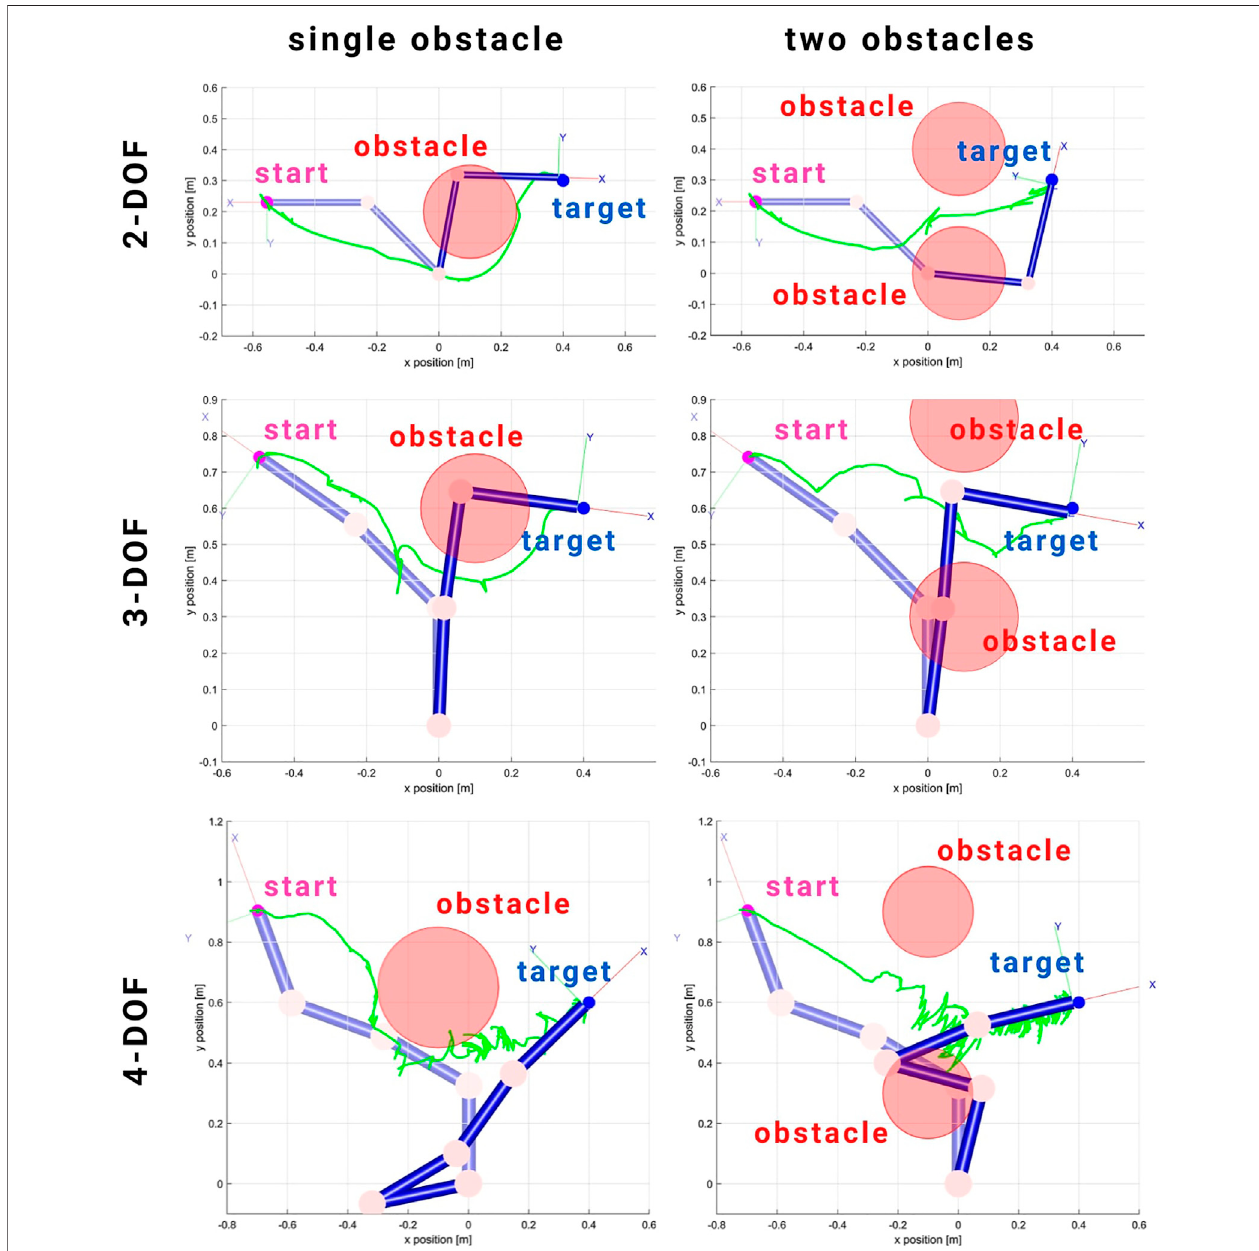
FIGURE 3 | Simulation results of simultaneous reaching and obstacle avoidance using KMF-PC on simulated 2-DOF, 3-DOF, and 4-DOF manipulator robots. It is noted in the 4-DOF case, where the complexity is relatively higher, more exploratory motion is triggered which caused the end effector to penetrate the virtual obstacle.